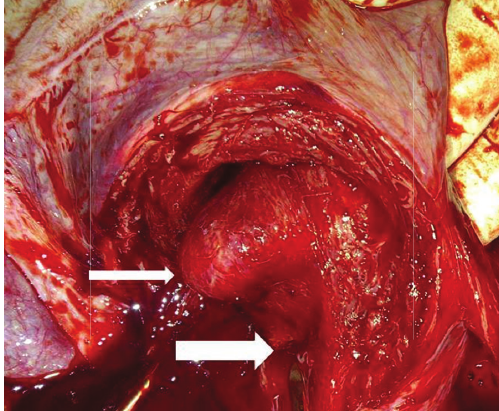
Figure 2: Dividing septum with a finger from the adjacent cavity (small arrow). Communication between the inferior edge of the septum and the internal cervical os (large